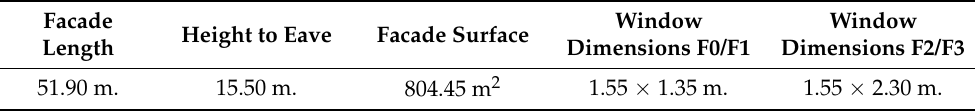
Table 5. Example of façade measurement table in the ALS LiDAR cloud.